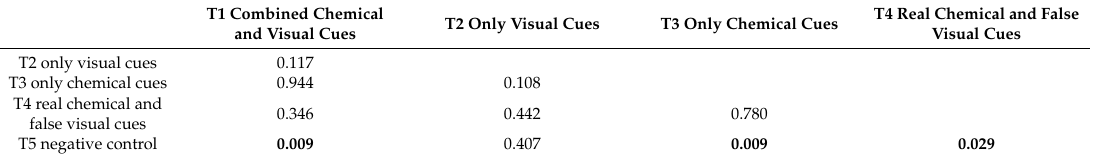
Table 9. Time spent ( ∆ t) by Octopus vulgaris in problem-solving. Wilcoxon matched-pairs test significance p -value, p -values < 0.05 are marked in